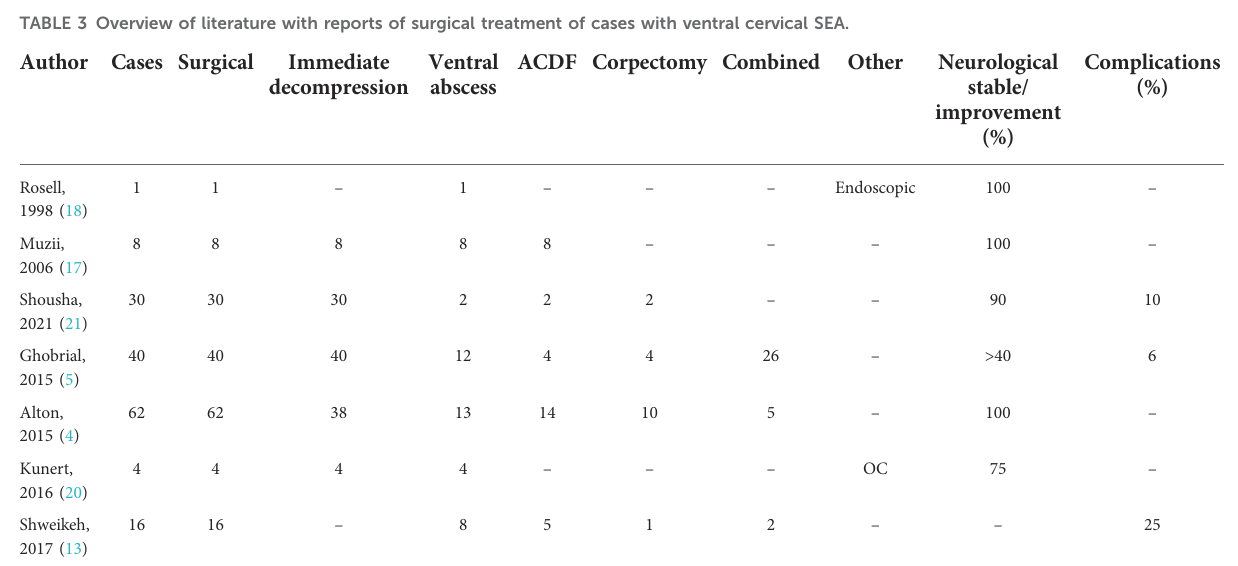
TABLE 3 Overview of literature with reports of surgical treatment of cases with ventral cervical